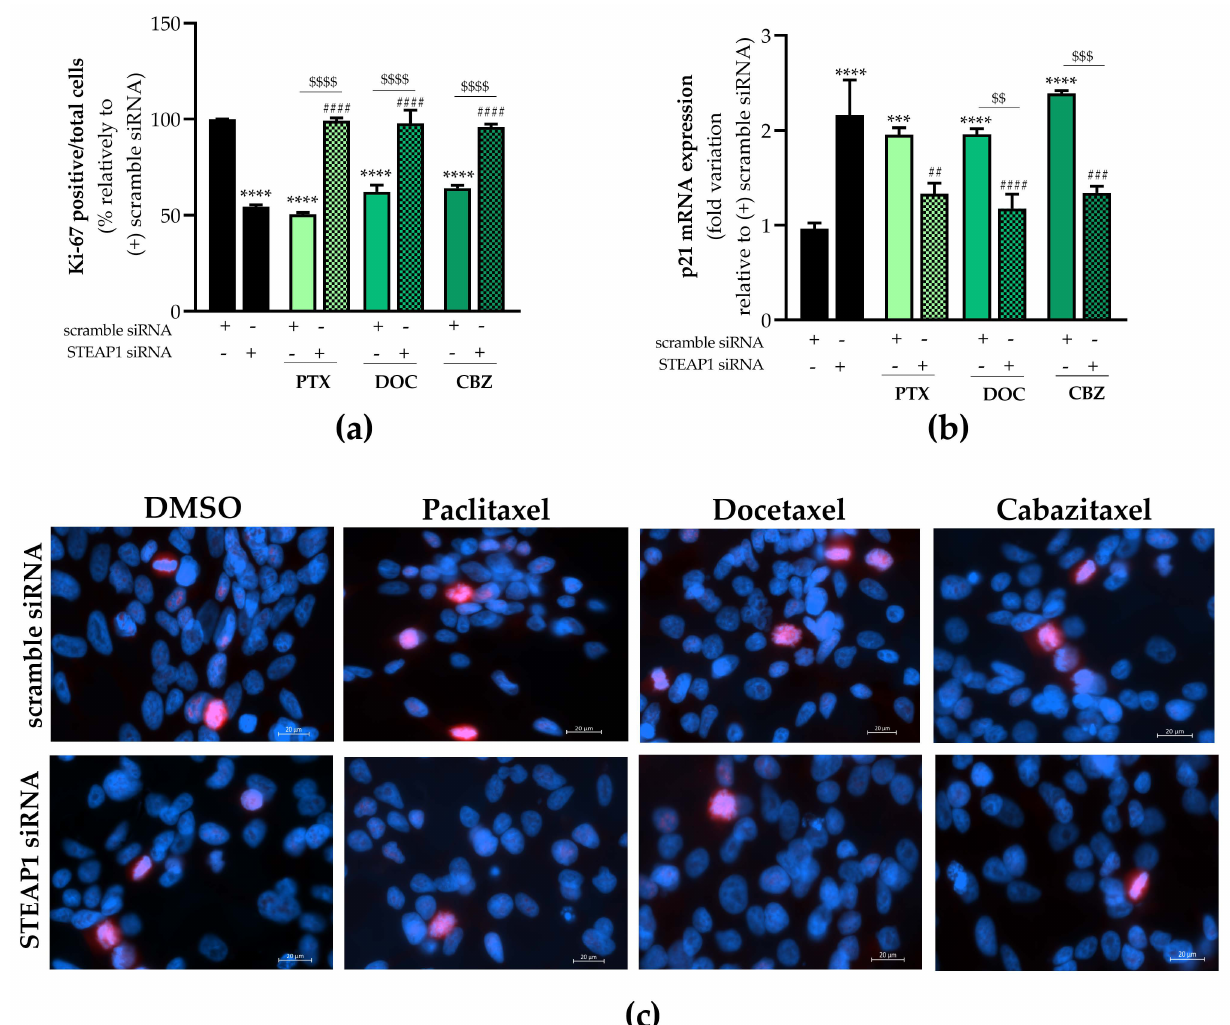
Figure 5. Effect of STEAP1 knockdown and paclitaxel, docetaxel or cabazitaxel on the proliferation activity on LNCaP cells. Human neoplastic LNCaP prostate cells were transfected with scramble or STEAP1 small interfering RNA (siRNA) for 24 h and treated with 5 nM paclitaxel (PTX), 20 nM docetaxel (DOC) or 1 nM cabazitaxel (CBZ) for an additional 24 h. The symbol “+” and “-” means presence or absence of the type of siRNA used in each experimental group. ( a ) Results of Ki- 67 immunofluorescence analysis, representing the number of Ki-67-positive cells out of total cell number. Expression of ( b ) p21 mRNA; expression levels were determined by RT-qPCR analysis after normalization with β 2M housekeeping gene. ( c ) Representative fluorescent immunocytochemistry images of Ki-67-labeled cells (red) and Hoechst 33342 stained nuclei (blue) obtained in the AxioImager Z2 microscope under 400 × magnification. Ten randomly selected fields per microscope cover glass were assessed. Results are expressed as percentage or fold-variation relative to scramble siRNA (control group). Error bars indicate mean ± S.E.M (n ≥ 2). *** p < 0.001 and **** p < 0.0001 when compared with the scramble siRNA group; ## p < 0.01, ### p < 0.001 and #### p < 0.0001 when compared with the STEAP1 siRNA group; and $$ p < 0.01, $$$ p < 0.001 and $$$$ p <